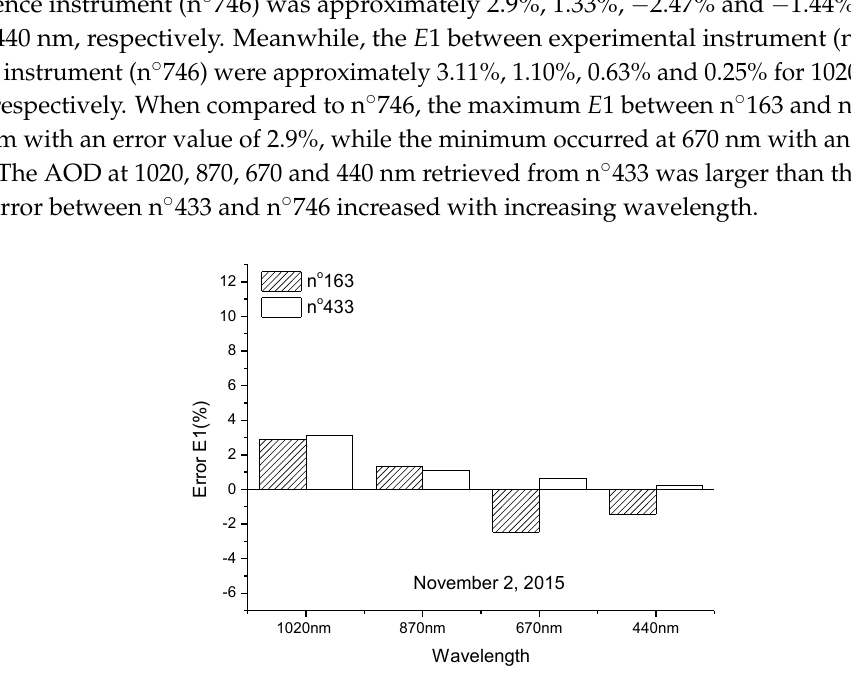
Figure 3. Daily mean and standard deviations of AOD at 1020 nm, 870 nm, 670 nm and 440 nm from the measurements of ( a ) n°163 and n°746, and ( b ) n°433 and n°746.